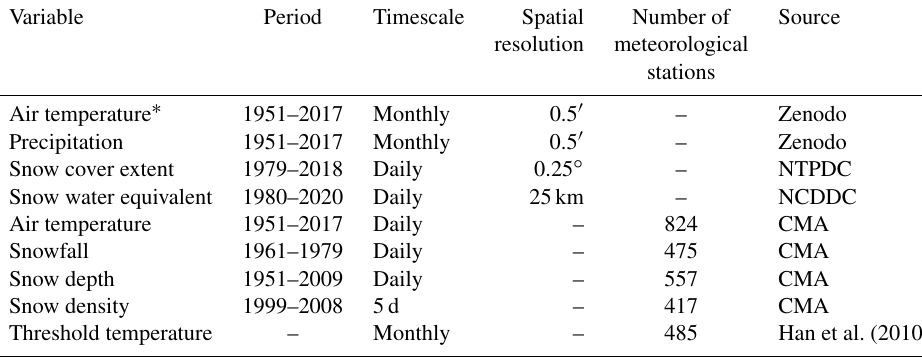
Table 1. Data used in the snowmelt model.